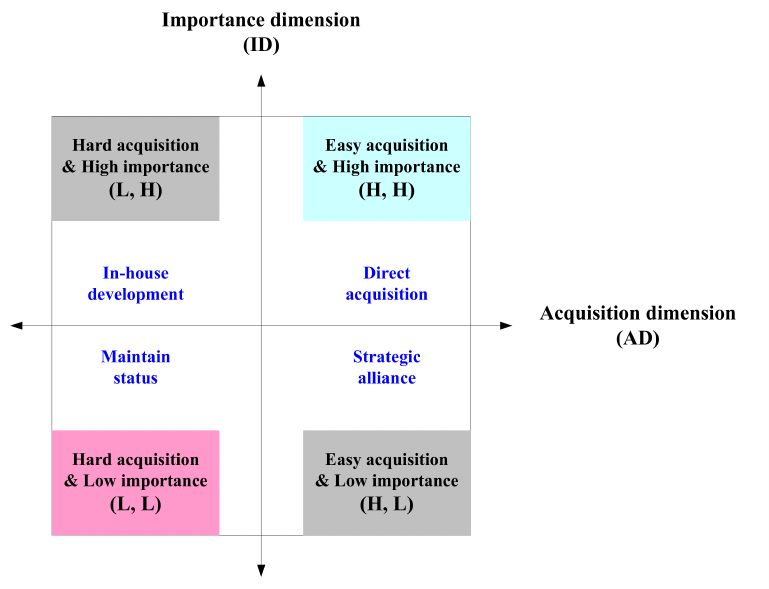
Figure 2. The concept map of AIA (acquisition–importance